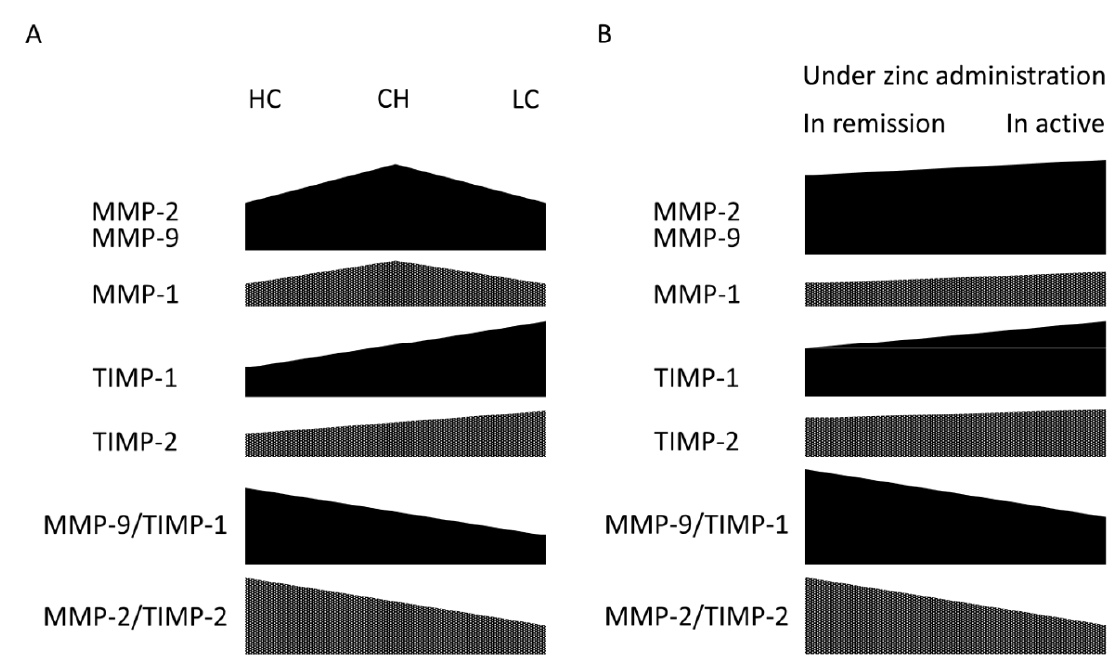
Figure 5. Scheme of the serum levels of matrix metalloproteinase (MMP) and its inhibitor (TIMP) in the course of liver disease progression and mechanistical working-hypothesis of the changes in MMP and TIMP levels under zinc administration. ( A ) Serum levels of MMPs and TIMPs in healthy carriers (HC), patients with chronic hepatitis (CH), and patients with liver cirrhosis (LC). ( B ) Serum levels of MMPs and TIMPs in patients with chronic liver disease in remission and in active phase.